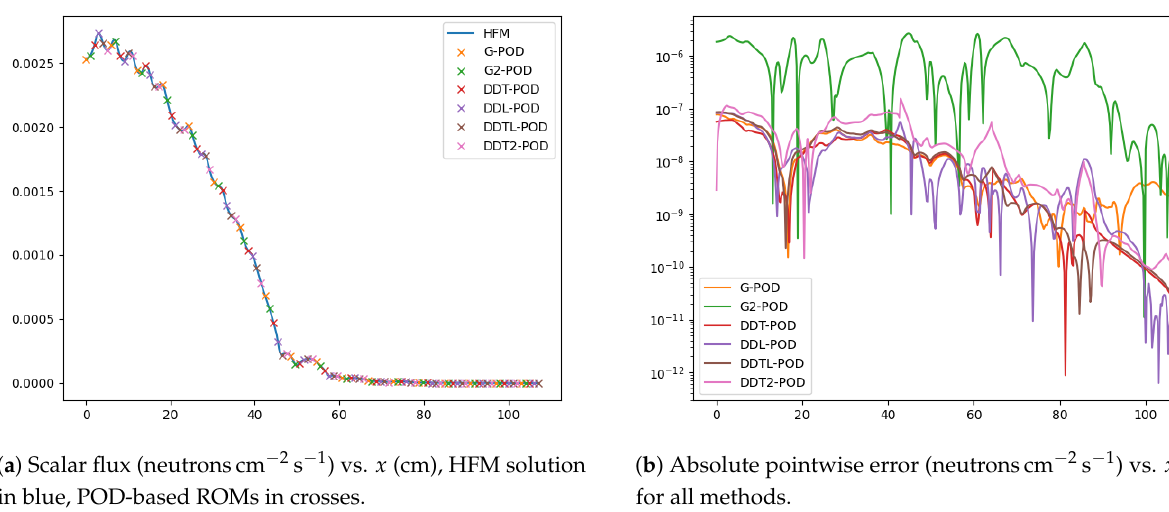
Figure 6. Scalar flux for Energy Group 9 for the HFM (blue) and POD methods and the pointwise error between them with parameters R 1 = 2, R 2 = 2, R 3 = 1, R 4 = 1, R 5 = 4.